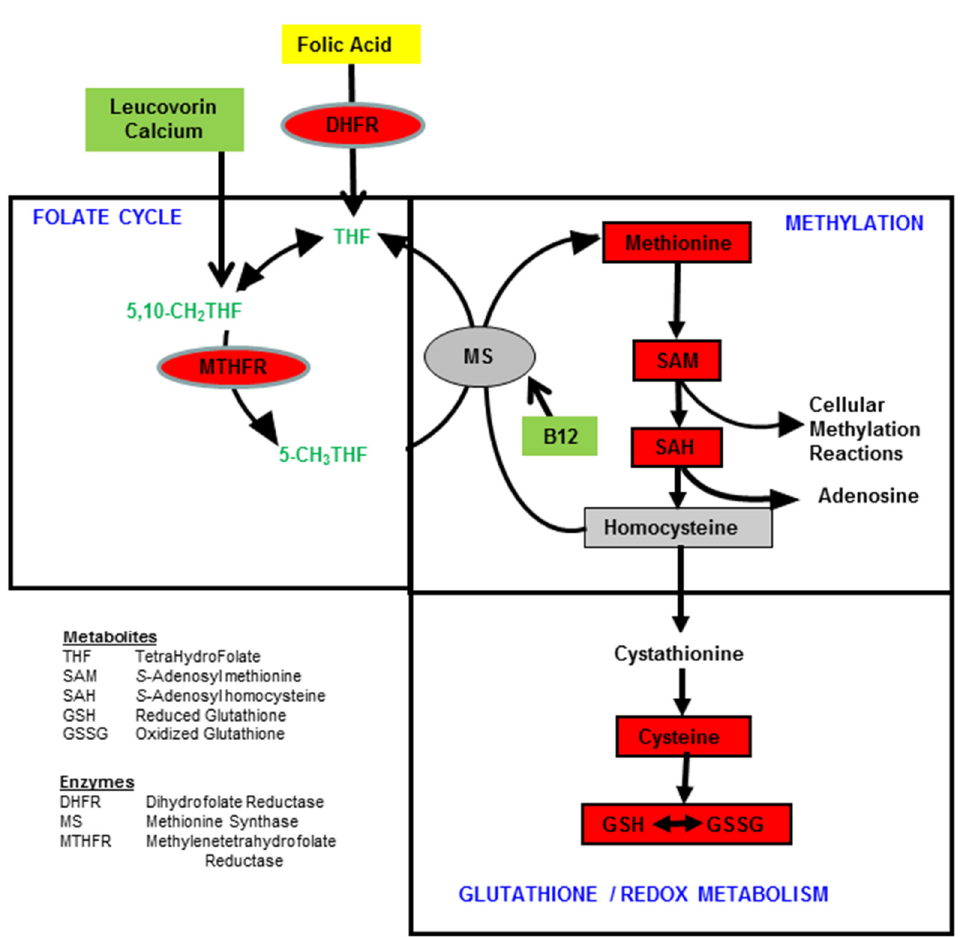
Figure 1. The connected folate, methylation, and redox cycles. Ovals represent enzymes and boxes represent metabolites. Red indicates metabolites and enzymes repeatedly noted to be consistently abnormal in ASD. Green highlights treatments that improve the metabolism of these cycles. Folic acid is shown in yellow as it is a suboptimal treatment because it is oxidized and has to be converted to active forms of folate.